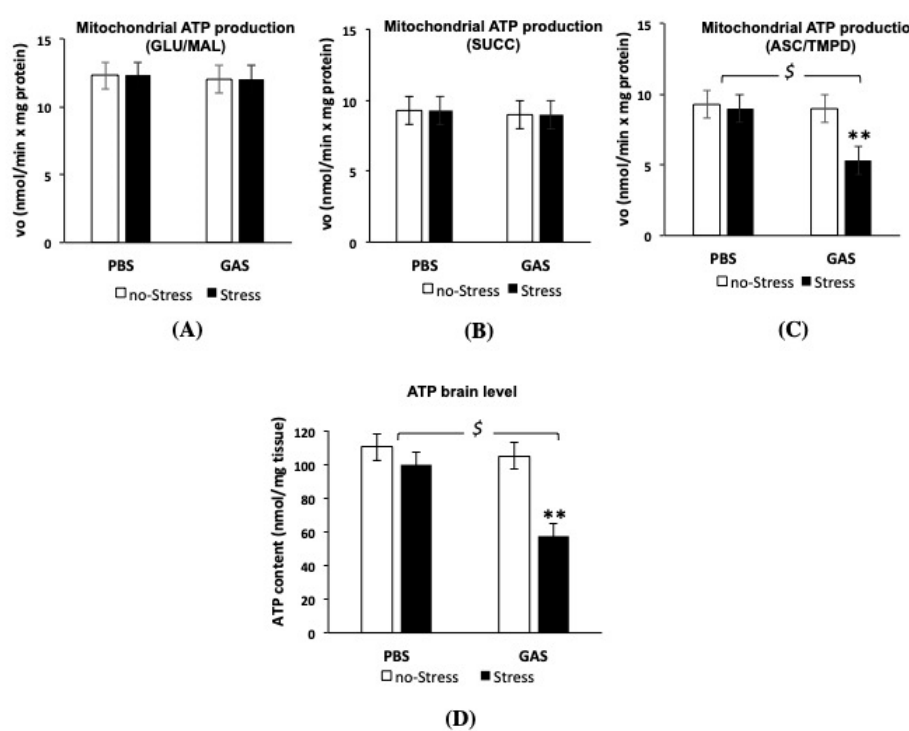
Figure 7. Mitochondrial ATP production and ATP level in the brain of GAS-Stress mice and relative controls. The rate of mitochondrial ATP production was measured in mitochondria isolated from cryopreserved brain hemispheres in the presence of the respiratory substrates of ( A ) complex I glutamate plus malate (GLU / MAL), ( B ) complex II succinate (SUCC) plus rotenone or ( C ) complex IV ascorbate plus TMPD (ASC / TMPD). Values are mean rates ± SD obtained from three independent experiments and expressed as nmol / min × mg protein. ( D ) The ATP level was measured as described in Material and Methods. Values are mean rates ± SD obtained from three independent experiments and expressed as nmol / mg protein. For the panels C and D $ p < 0.05 for PBS-Stress vs. GAS-Stress. ** p < 0.01 for GAS no-Stress vs. GAS-Stress. Cohen’s d measures are reported in Table